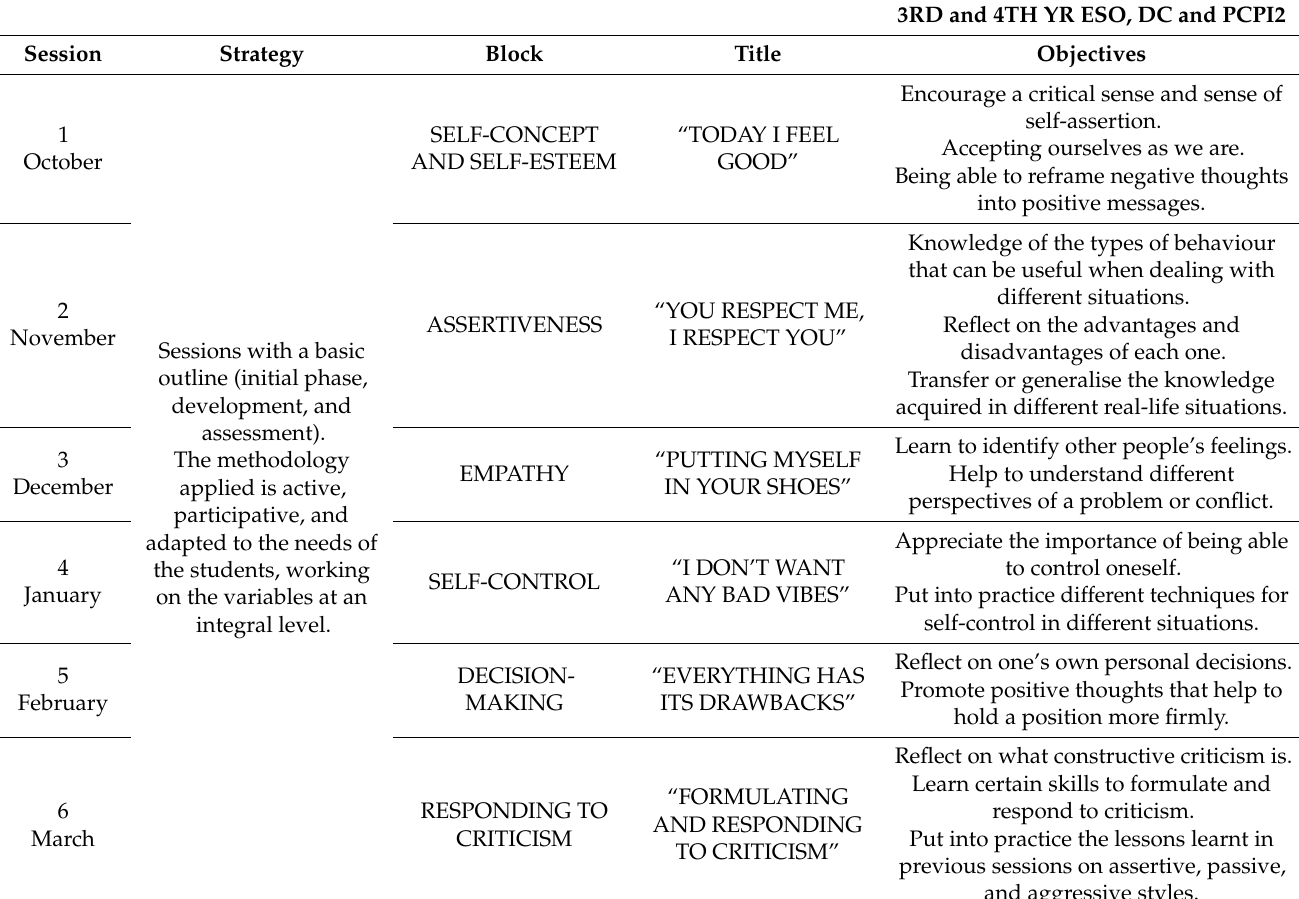
Table 2. Structure of the intervention programme for 3RD and 4TH YR ESO, DC and PCPI2.